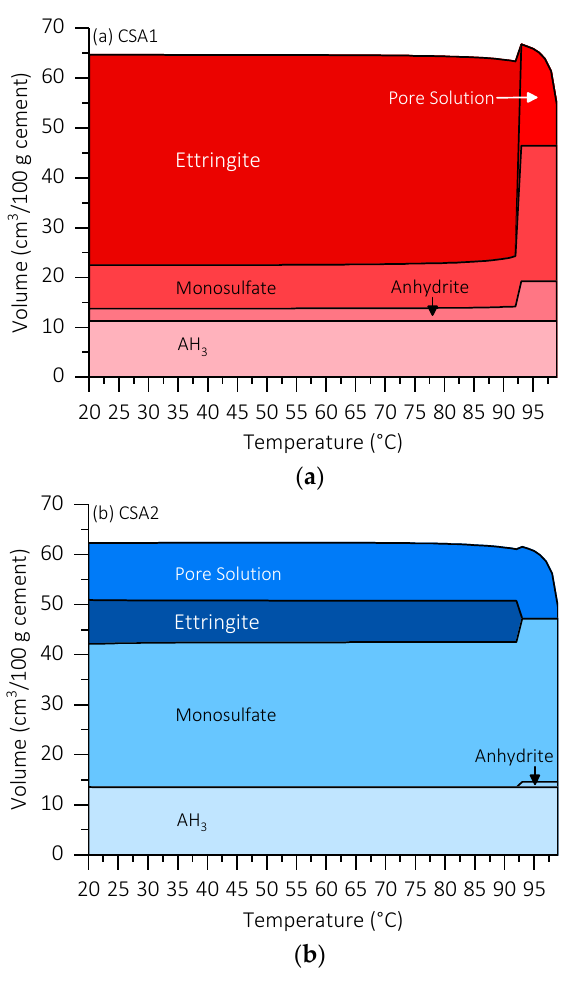
Figure 11 . Thermodynamic modeling showing effect of elevated curing temperature on ye’elimite and anhydrite hydration with a w/c = 0.5 for ( a ) CSA1 and ( b ) CSA2.